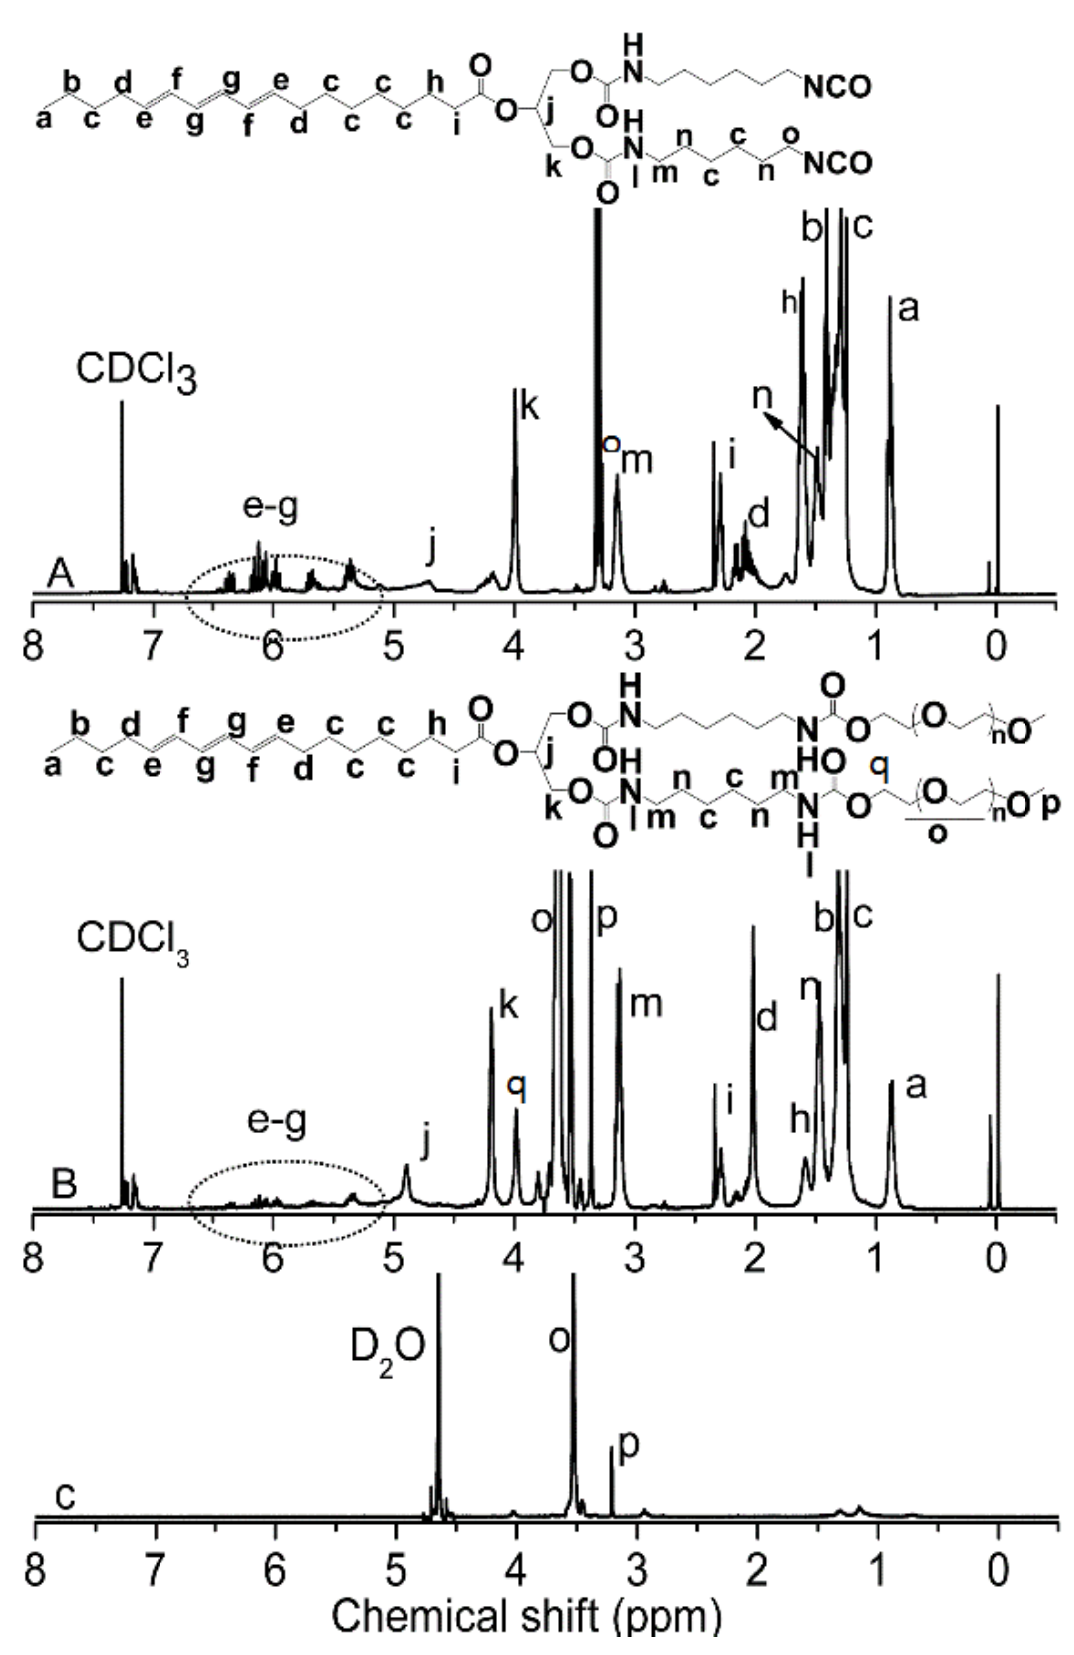
Figure 2. 1 H NMR spectra of ( A ) NCO-HTO-NCO and ( B ) m PEG-HTO- m PEG-2 in CDCl 3 , and ( C ) m PEG-HTO- m PEG-2 in D 2 O.